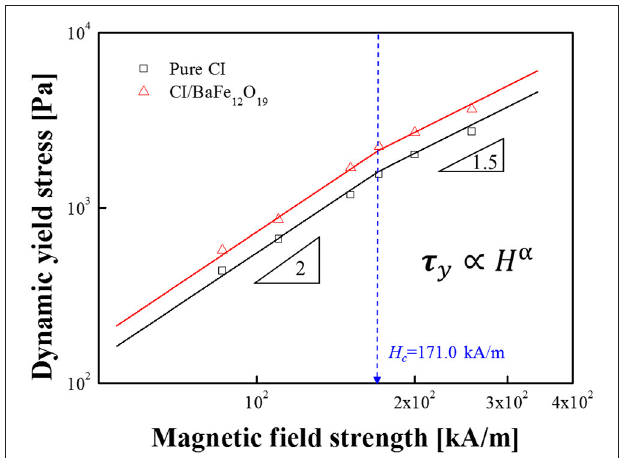
FIGURE 6 | Strain amplitude sweep test for pure carbonyl iron (CI; closed symbol) and CI/BaFe 12 O 19 mixture–(open symbol) based magnetorheological (MR) fluids under various magnetic field strengths.